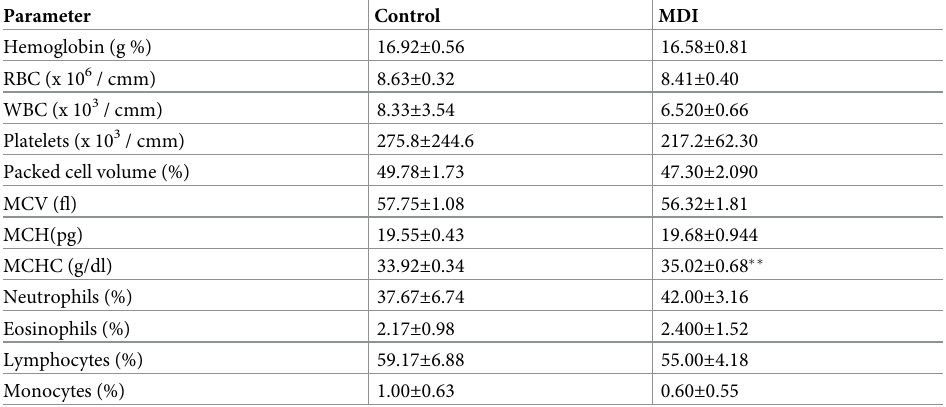
Table 4. Effect of MDI on hematological parameters of female rats in the acute toxicity.